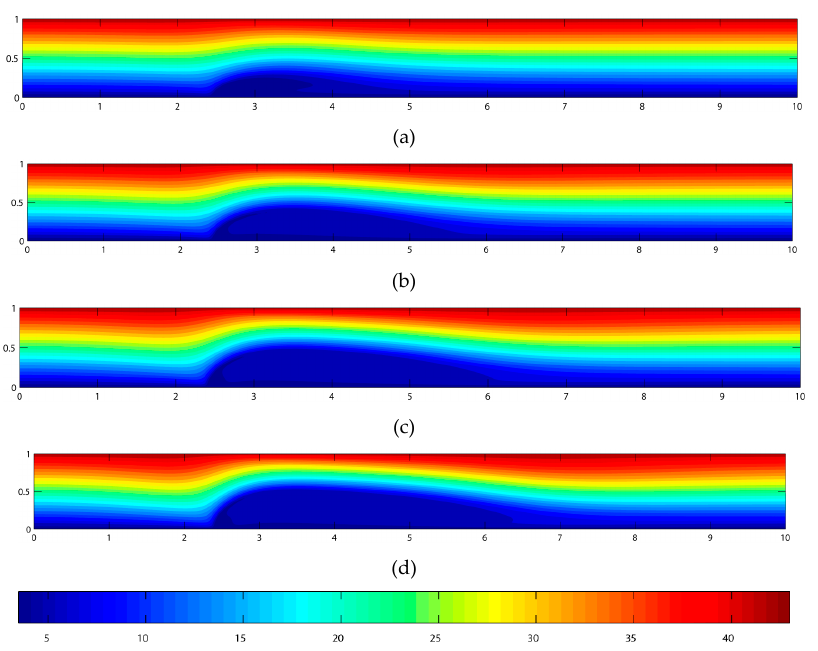
Figure 5. Temperature contour plots for biomagnetic flow subjected to B o of ( a ) 2 T; ( b ) 4 T; ( c ) 6 T; and ( d ) 8 T.